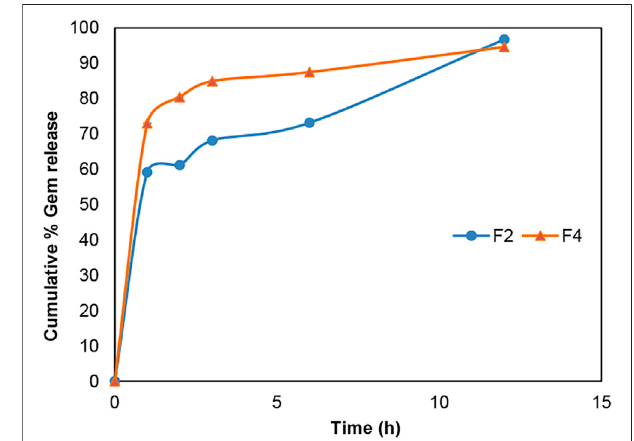
FIGURE 6 | Cumulative drug release pro fi le of gemcitabine in Gem + LCNPs, F2 and Gem:Re + LCNPs, F4 in various ratios over 12 h period. The graph represents the percentage of gemcitabine concentration released over 12 h (n = 3).